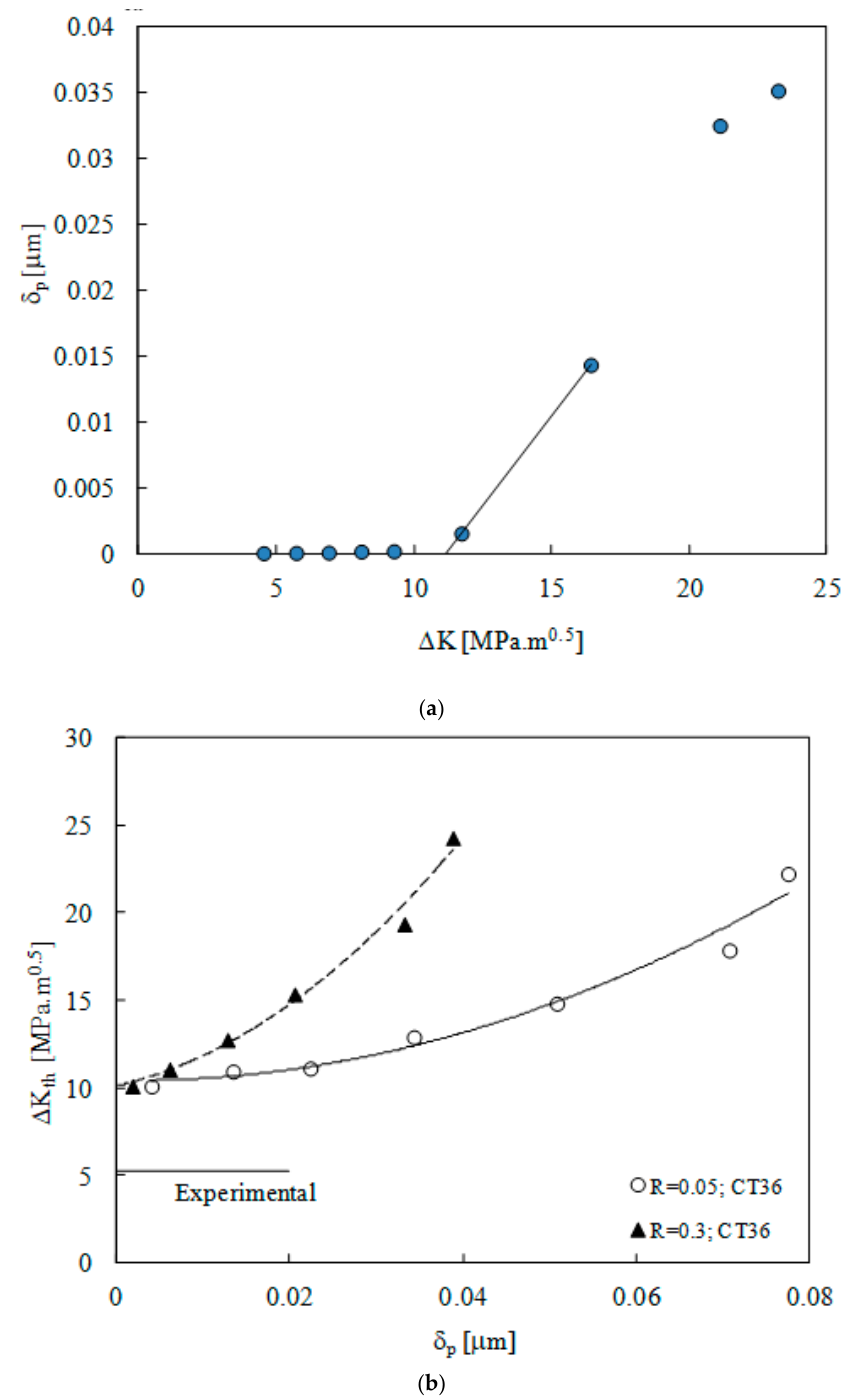
Figure 10. Numerical prediction of fatigue threshold. ( a ) Constant K max approach (a = 17.272 mm; K max = 23.4 MPa.m0.5). ( b ) Analysis based on the CTOD versus load plots.